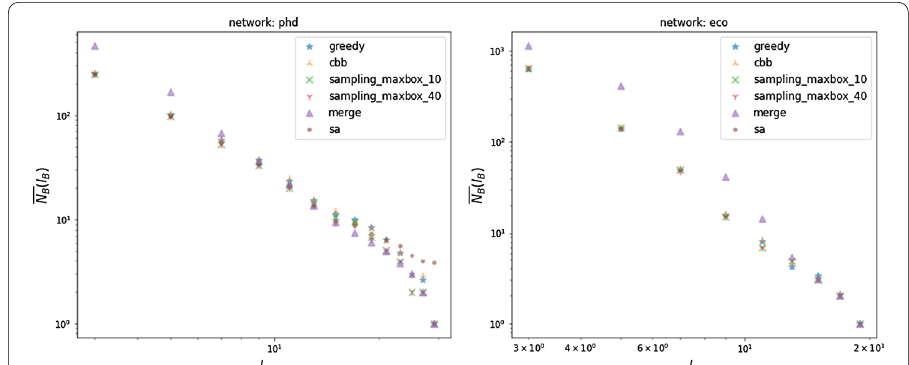
Fig. 8 The mean N B against l B computed on the Ph.D. and E. Coli networks with five algorithms